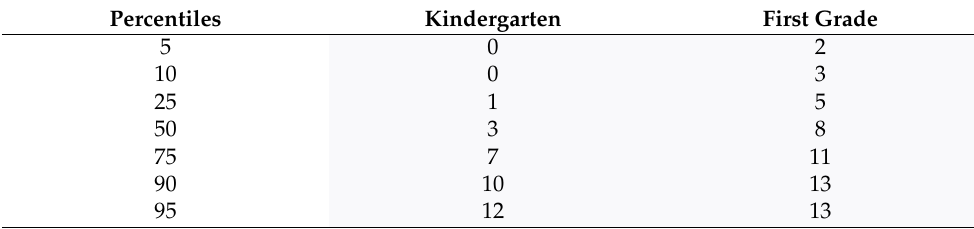
Table A1. Phonological awareness of the initial